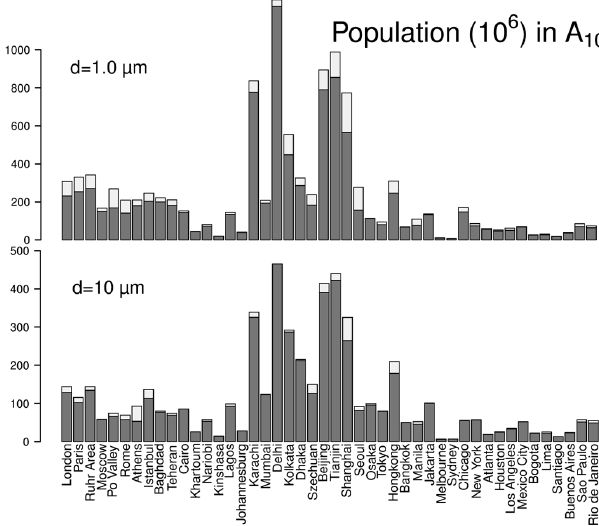
Fig. 9. Population in millions which reside in A 10 for 1 . 0µm (top panels) and 10 . 0µm (bottom panels) aerosol tracers. Dark and light gray bars are defined as